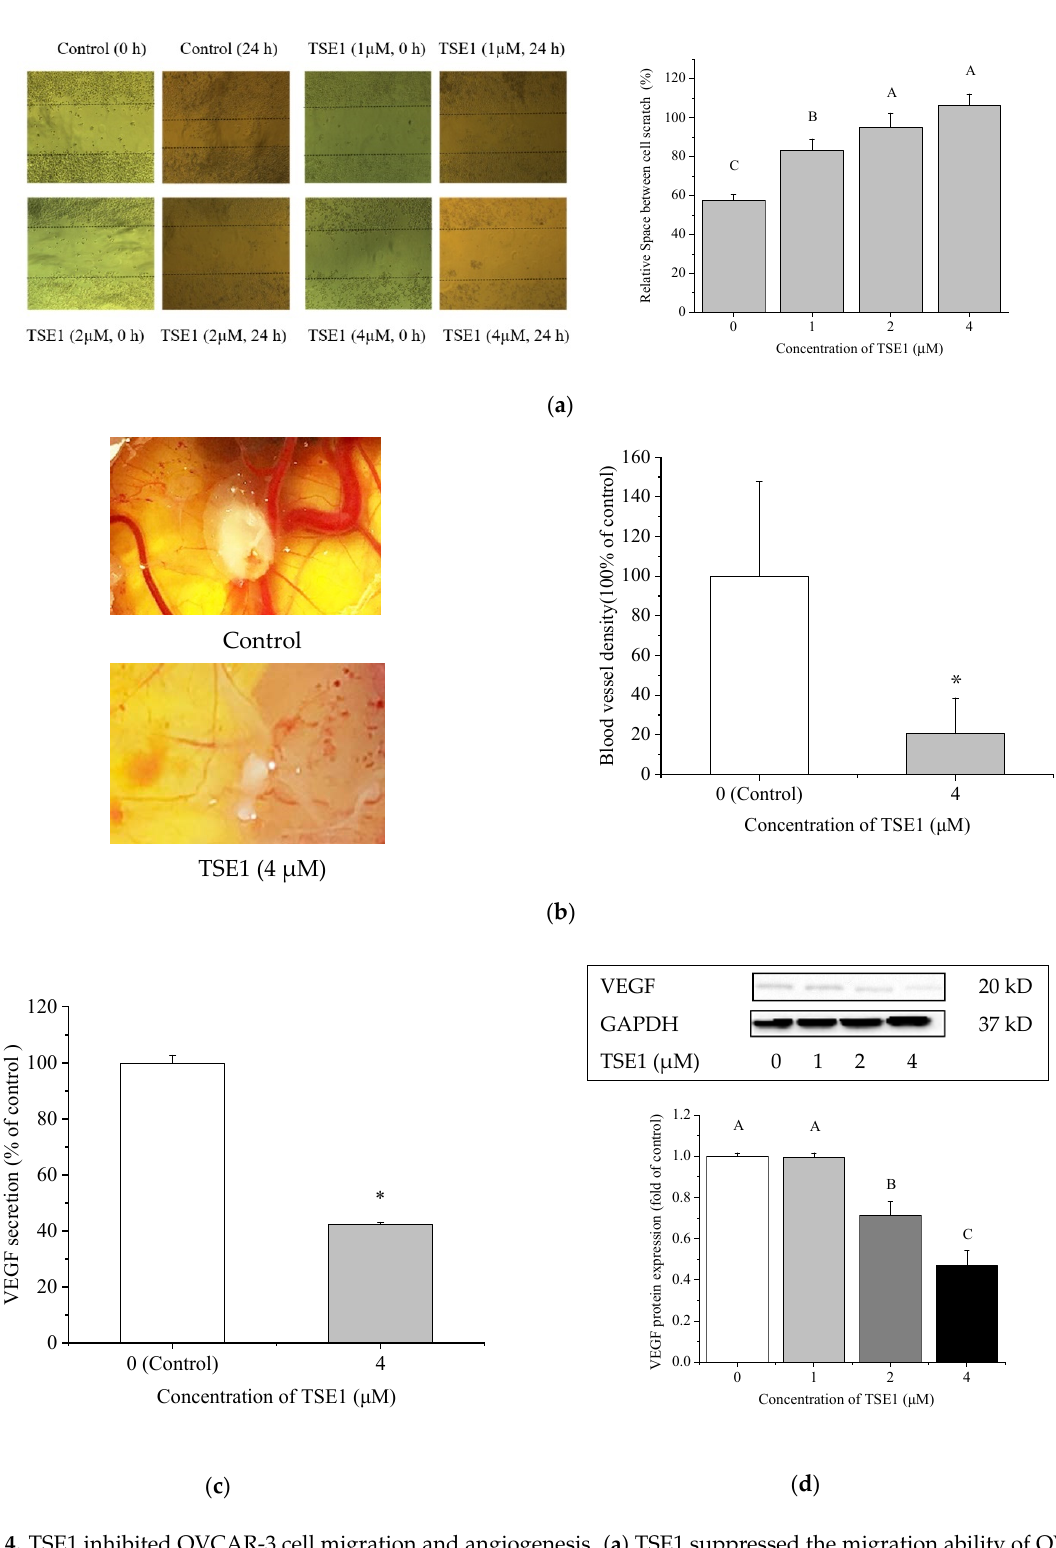
Figure 4. TSE1 inhibited OVCAR-3 cell migration and angiogenesis. ( a ) TSE1 suppressed the migration ability of OVCAR-3 cells determined by a wound healing assay after 24 h treatment. ( b ) TSE1 inhibited OVCAR-3 cell-induced blood vessel development in the chicken chorioallantoic membrane (CAM) model. ( c ) TSE1 inhibited VEGF secretion in OVCAR-3 cells analyzed by ELISA. ( d ) TSE1 reduced the VEGF protein level in OVCAR-3 cells detected by Western blot. Results were expressed as mean ± SD from three independent experiments. Significant differences among different treatments are marked with different letters ( p < 0.05). * p < 0.05 versus